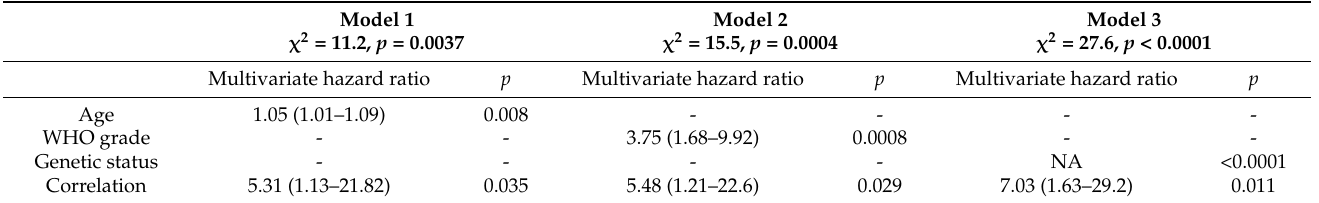
Table 5. Multivariate associations with all-cause death for correlation.